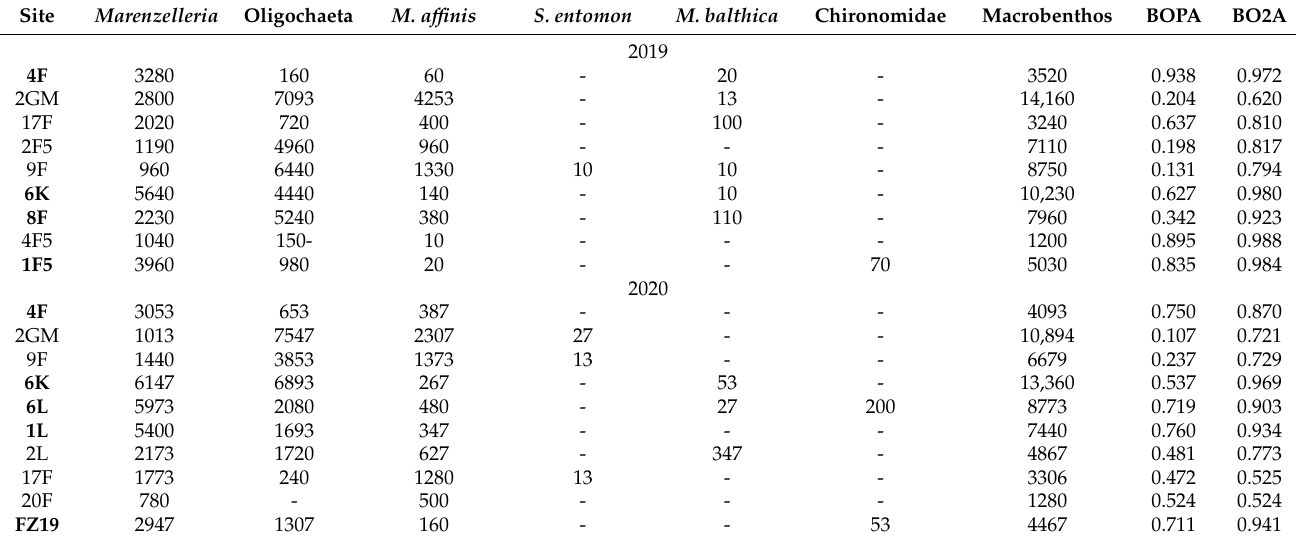
Table 1. Abundance (ind. m − 2 ) of macrobenthic taxa, Benthic Opportunistic Polychaetes Amphipods (BOPA) and Benthic Opportunistic Annelida Amphipods (BO2A) indices. Coastal sites are marked in bold.